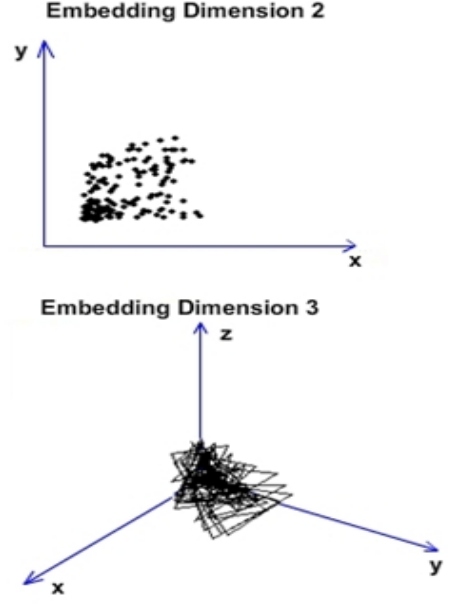
Figure 5. Attractor reconstruction from Figure 4.